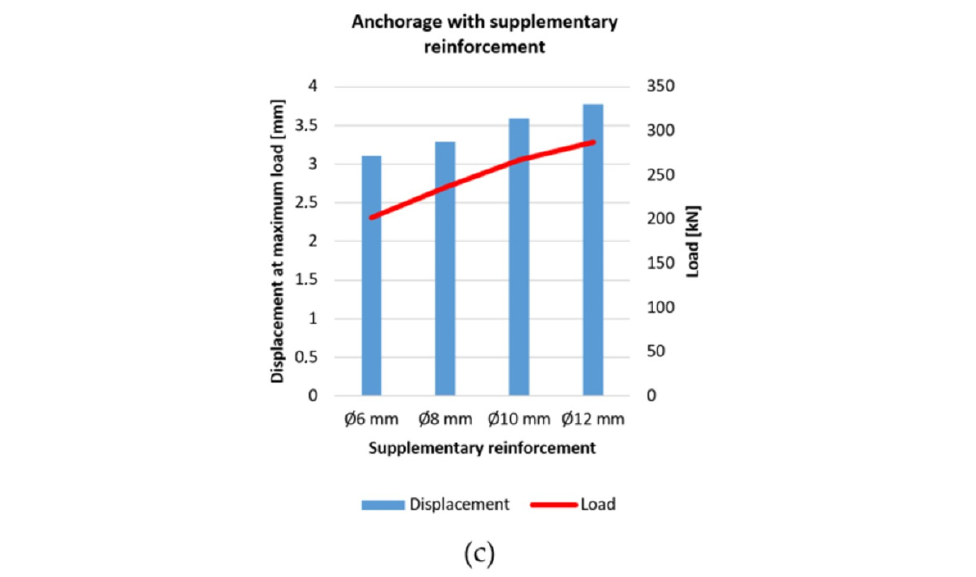
Figure 22. Comparison of parametric study results: ( a ) anchorage without supplementary reinforcement—compressive concrete strength effect; ( b ) anchorage with supplementary reinforcement—compressive concrete strength effect; ( c ) anchorage with supplementary reinforcement—reinforcement diameter effect.